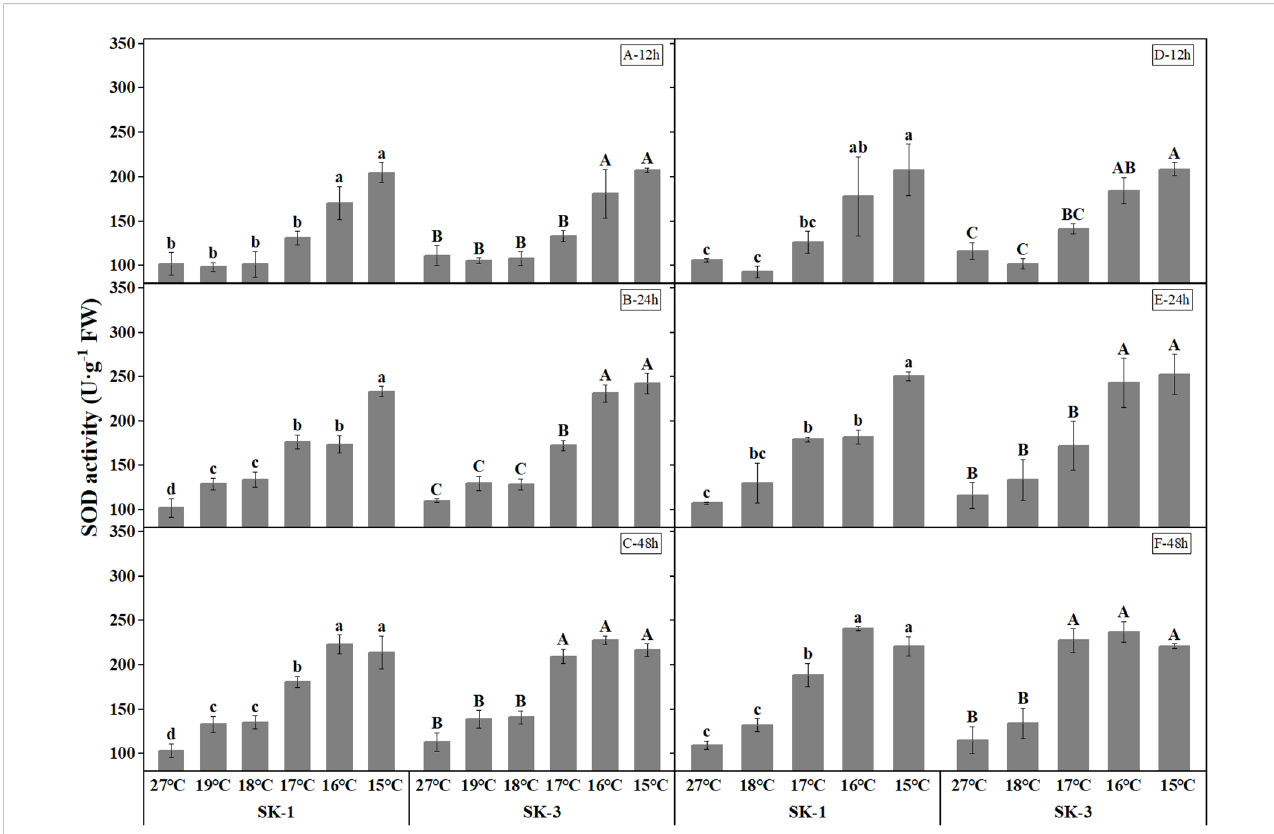
FIGURE 6 Effect of low temperature stress on SOD activity in cotton squares in 2020 ( A-C : 12h, 24h, 48h stress) and 2021 ( D-F : 12h, 24h, 48h stress). FW represents fresh weight. Different lowercase letters indicate the signi fi cant differences between the treatments of the variety SK1, and different capital letters indicate the signi fi cant differences between the treatments of the variety SK3 (P<0.05).